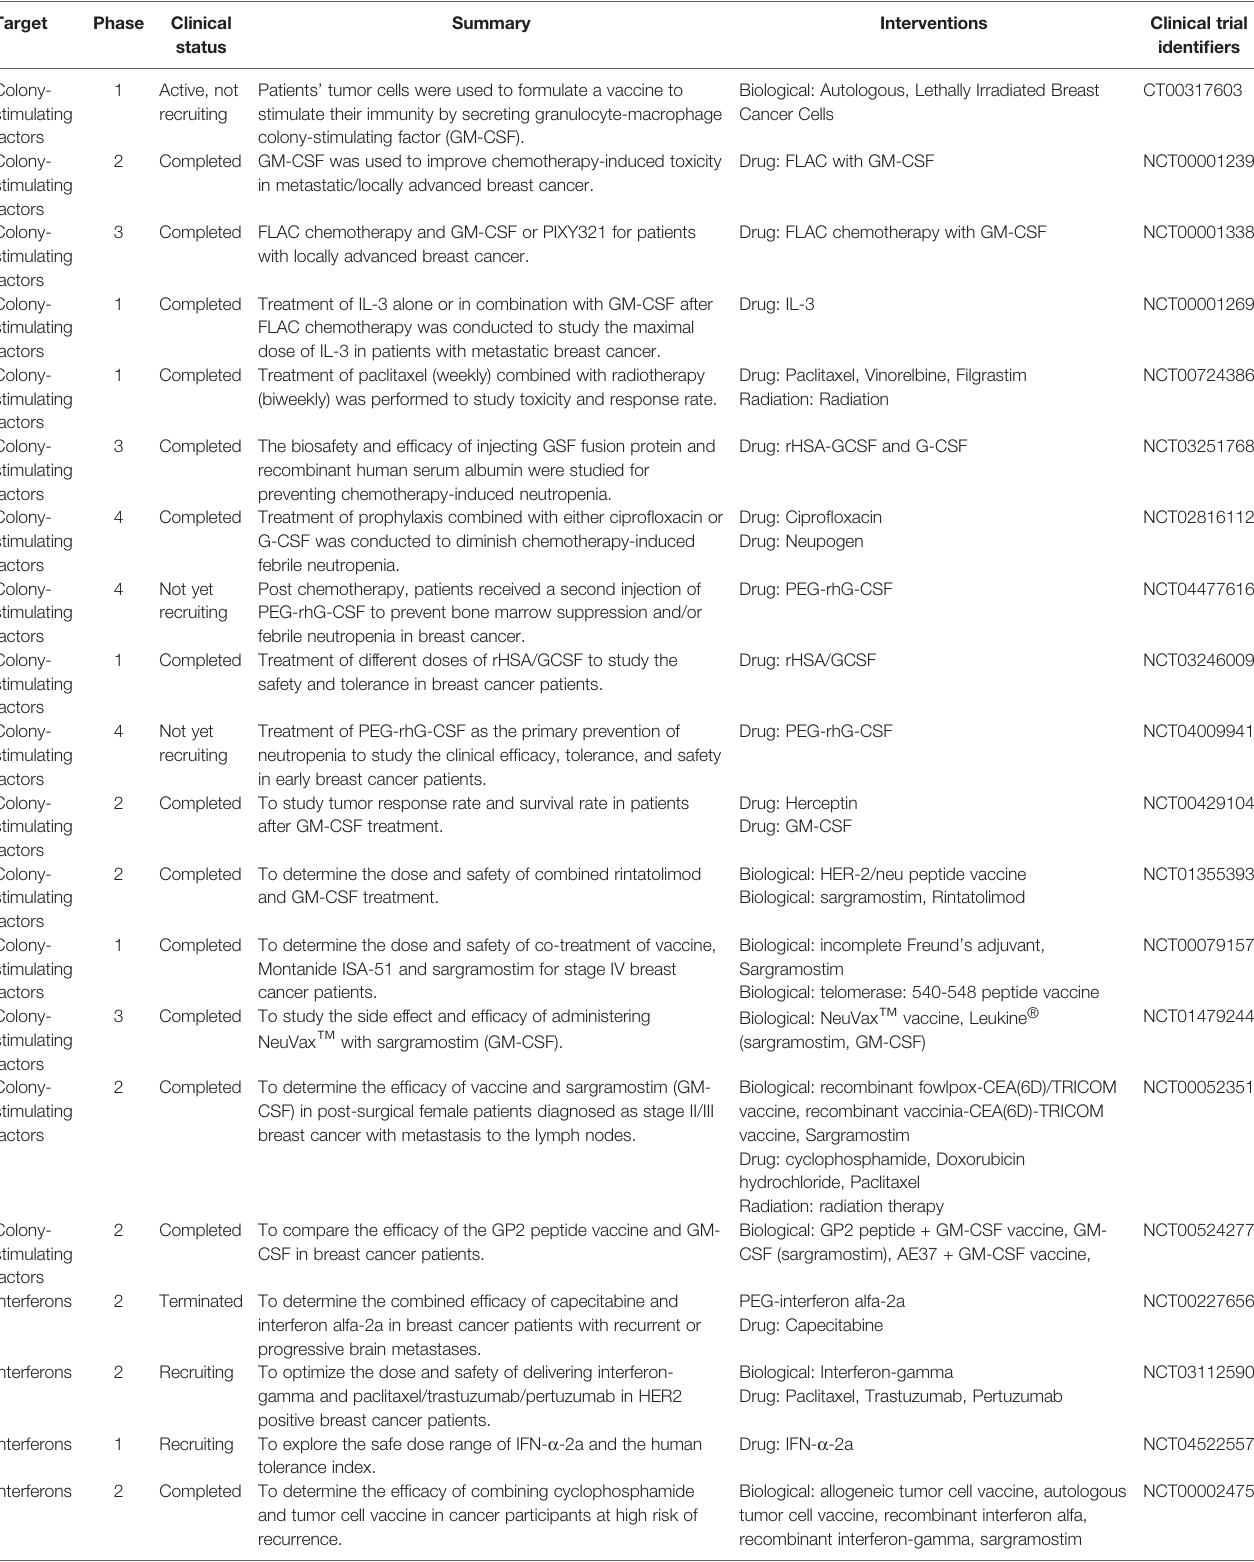
TABLE 2 | Clinical applications and current trials of innate immunity-based breast cancer